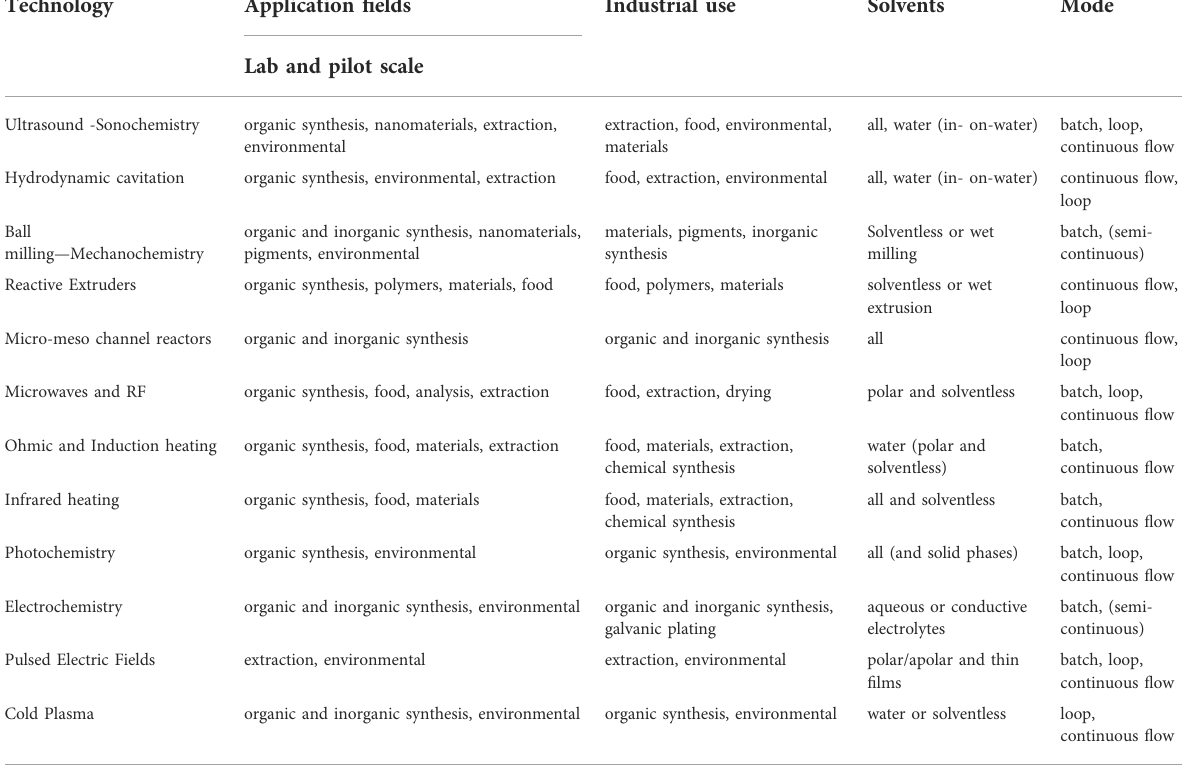
TABLE 1 Enabling technologies for process intensi fi